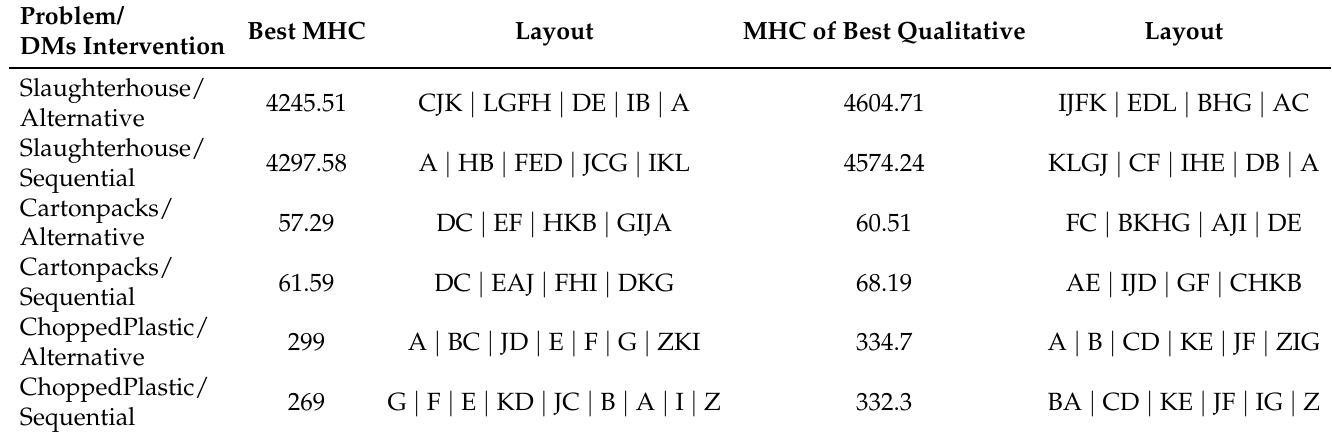
Table 8. Summary of best layouts found applying only quantitative criteria and including qualitative